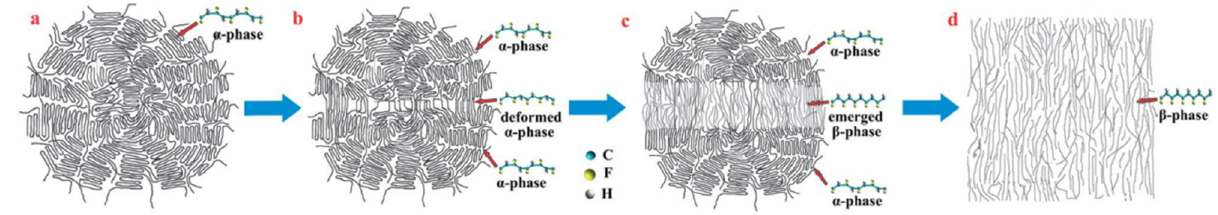
Figure 12: Schematic drawing of the transformation process from α - crystal to β - crystal of PVDF by mechanical stretching [ 23 ]